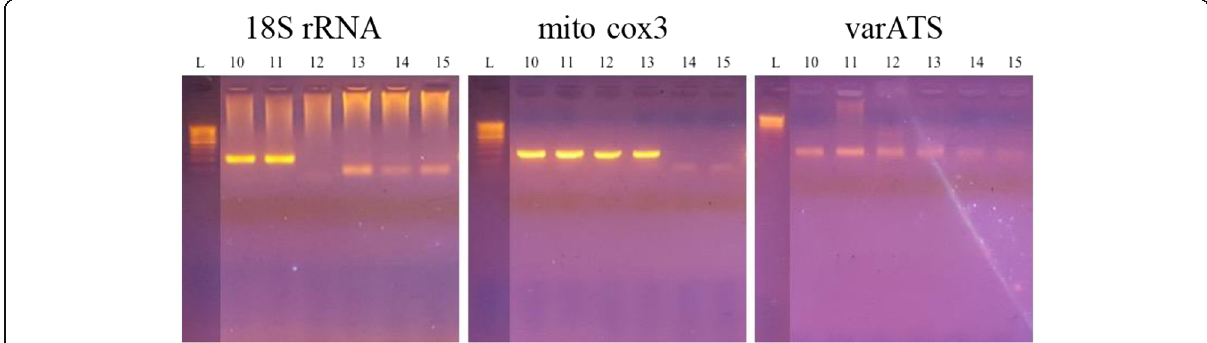
Fig. 1 Representative photographs of gel electrophoresis for 18S rRNA, cox3 , and varATS primers using six saliva DNA samples (sample nos. 10 – 15). Sample nos. 10 and 11 were positive with 18S rRNA, since distinct bands of the correct size were visible; sample nos. 10 through 13 were positive with cox3 ; and sample nos. 10 and 11 were positive with varATS primers, but sample nos. 12 – 15 were difficult to score. The gel pictures show brighter and more distinct bands for cox3 than 18s rRNA and